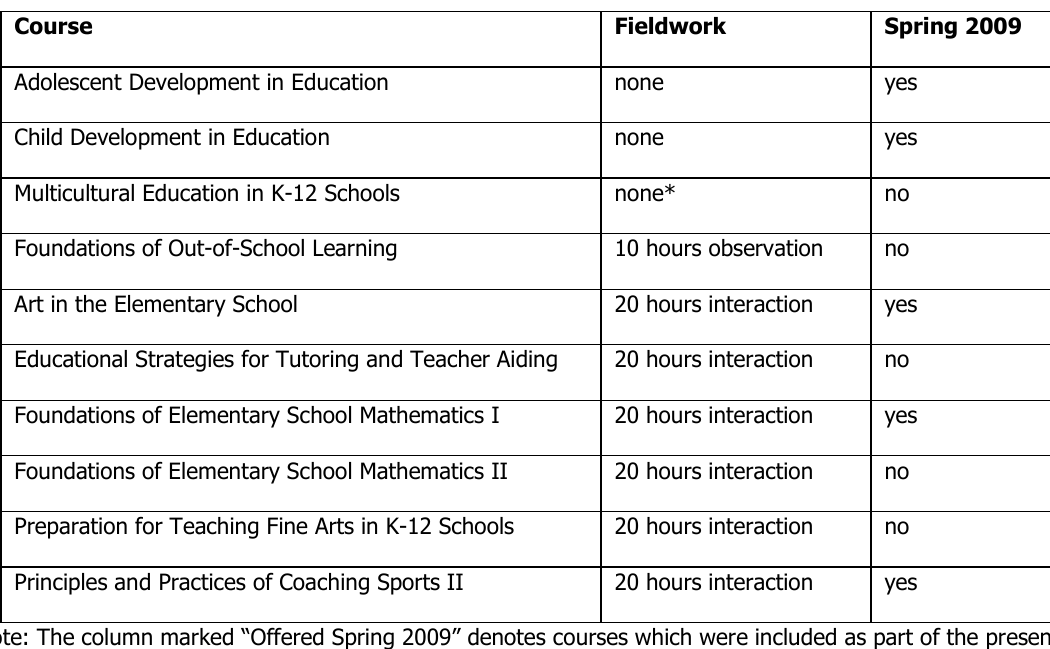
Amount and type of fieldwork required in CASE